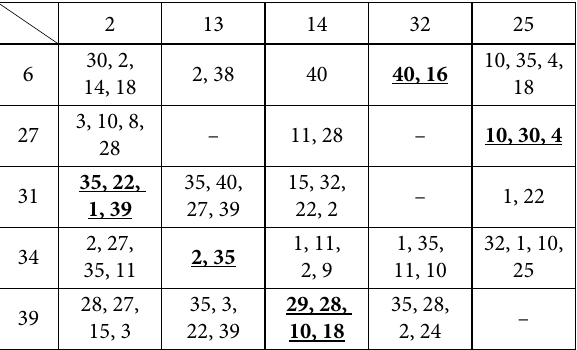
Table 7. Deducing the principle of invention of